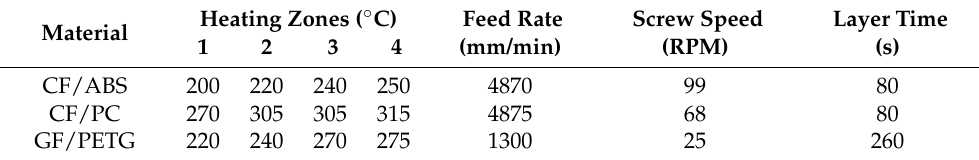
Table 2. Material processing